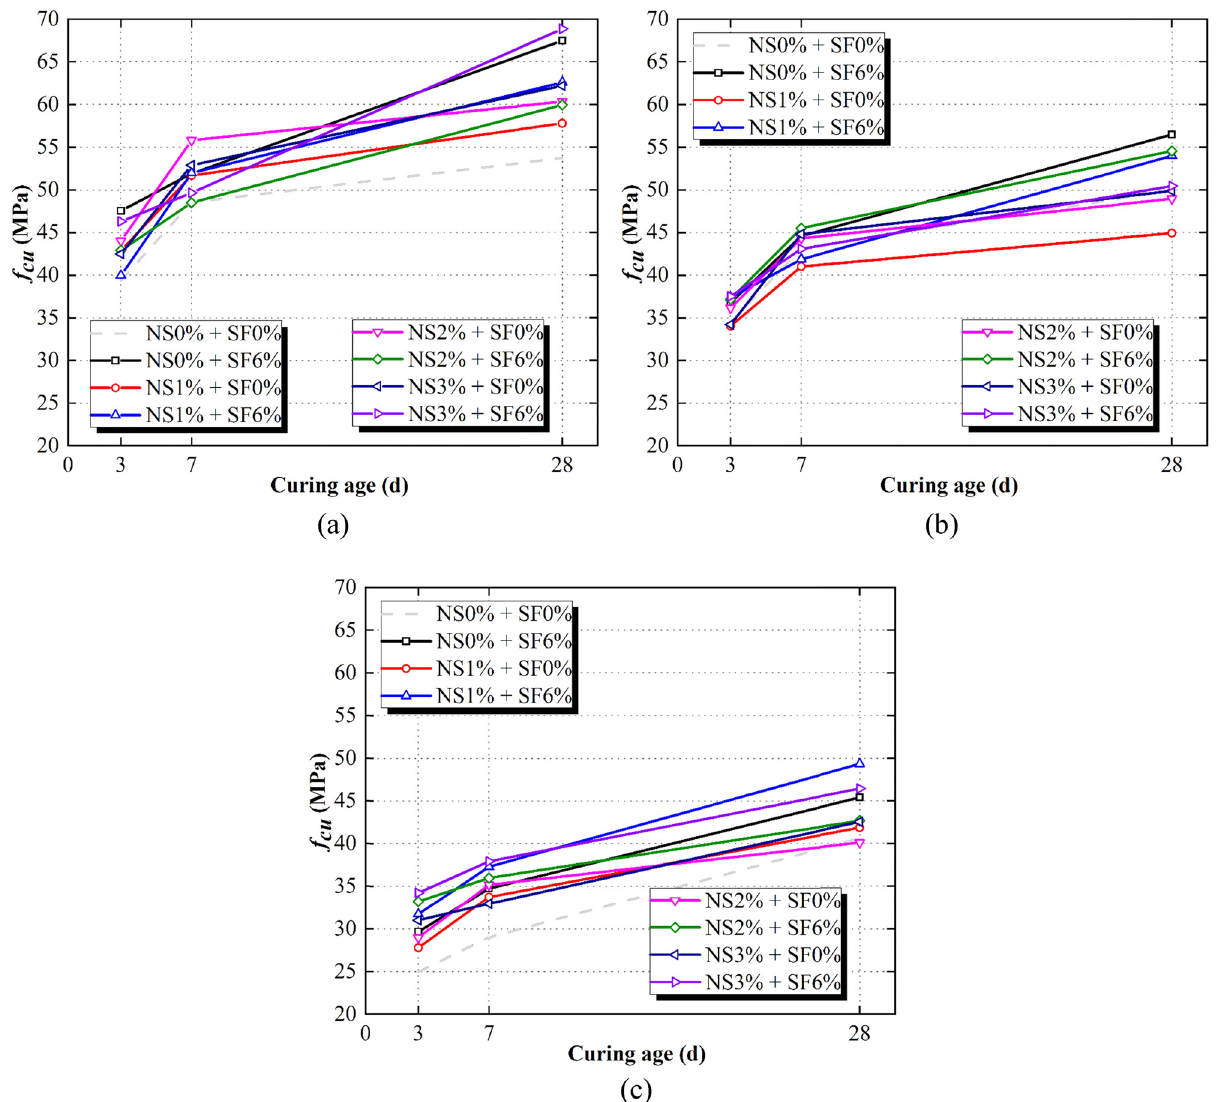
Figure 9: E ff ect of curing age on the cubic compressive strength of specimens with ( a ) 0%, ( b ) 50%, and ( c ) 100% RA